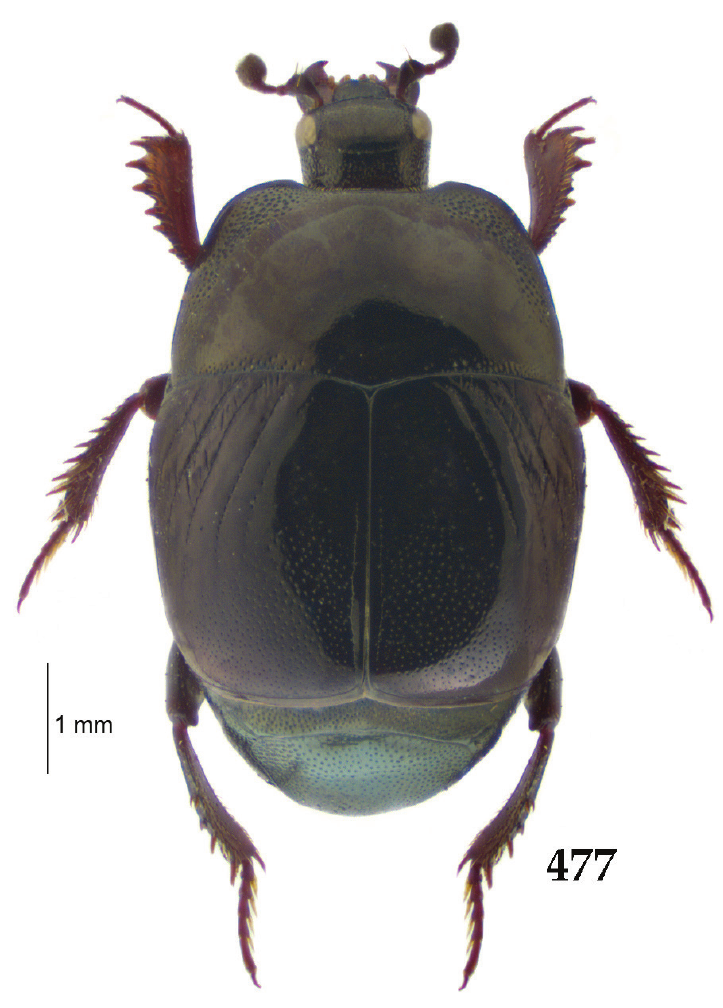
Figure 477. Saprinus ( Saprinus ) nitiduloides Fairmaire, 1883 habitus, dorsal Type material examined. Saprinus nitiduloides Fairmaire, 1883: Lectotype, pre- sent designation, ♂ , side-mounted on a triangular mounting card, with terminalia glued on another triangular card under the specimen, right metatarsus missing, with the following labels: “Fairmaires / unique specimen / given me in Paris / 8.5.[18]88” (written); followed by: “ Saprinus / nitiduloides / Fairm. /Mioko” (written); followed by: “G. Lewis Coll. / B.M. 1926-369.” (printed); followed by: “Type” (round, red- margined label); followed by: “09-087” (yellow, pencil-written label, added by the senior author); followed by: “Saprinus / nitiduloides / Fairmaire, 1883 / LECTOTYPE / des. T. Lackner ‘11” (red label, written) (BMHN). Although Fairmaire (1883:3) does not mention the number of specimens he based his description of S. nitiduloides on, he